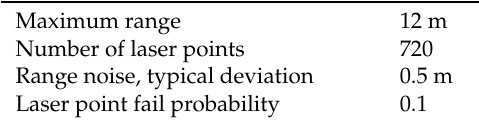
Table 1. Simulated LIDAR parameters.